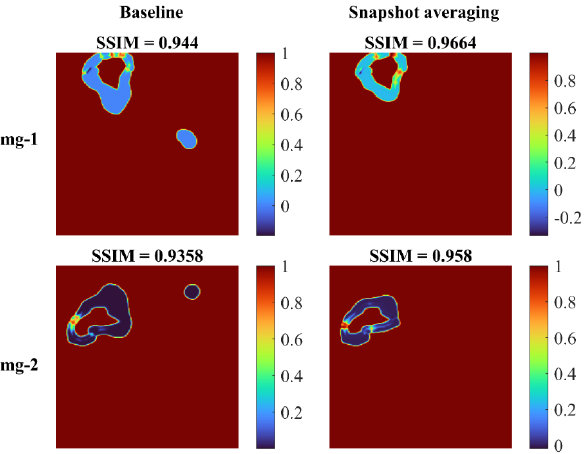
Figure 8. SSIM quality maps shown for the predictions achieved for a couple of test CXRs, by the baseline (Inception-V3 UNet model trained with lung-cropped CXRs/masks at the 256 × 256 resolu- tion), and the snapshot averaging of the top-5 model snapshots with their optimal TTA combination. We observed higher values for the SSIM using the snapshot averaged predictions compared to the baseline, signifying that the predicted masks were increasingly similar to the ground truth masks. Snapshot averaging removed the false positives, and demonstrated improved prediction similarity to the ground truth, with a higher SSIM value, compared to the